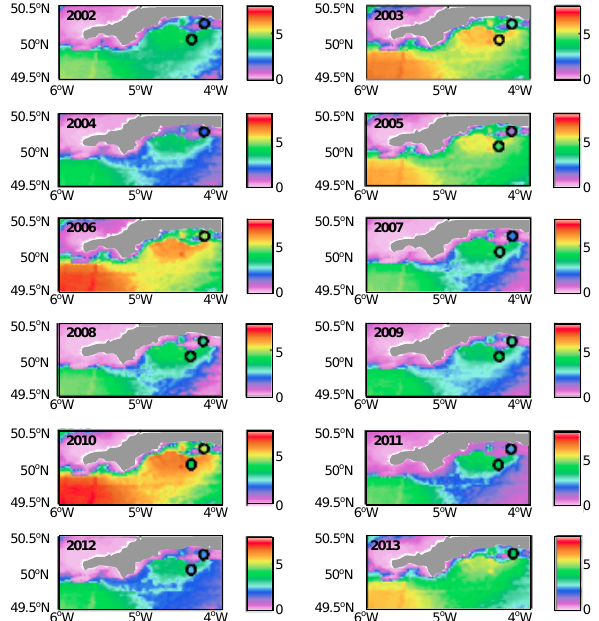
Figure 5. Surface–bottom temperature differences ( ◦ C) in the west- ern English Channel, on day 190 of 2002–2013. Coloured circles indicate the coincident temperature differences at L4 and E1, sub- ject to data availability (E1 data are unavailable in 2004, 2006 and